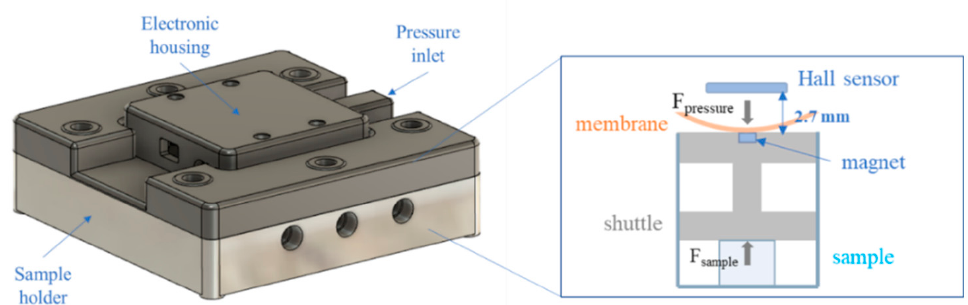
Figure 1. Technical drawing of the low-force MCTR bioreactor ( right ) and representation of one well ( left ).